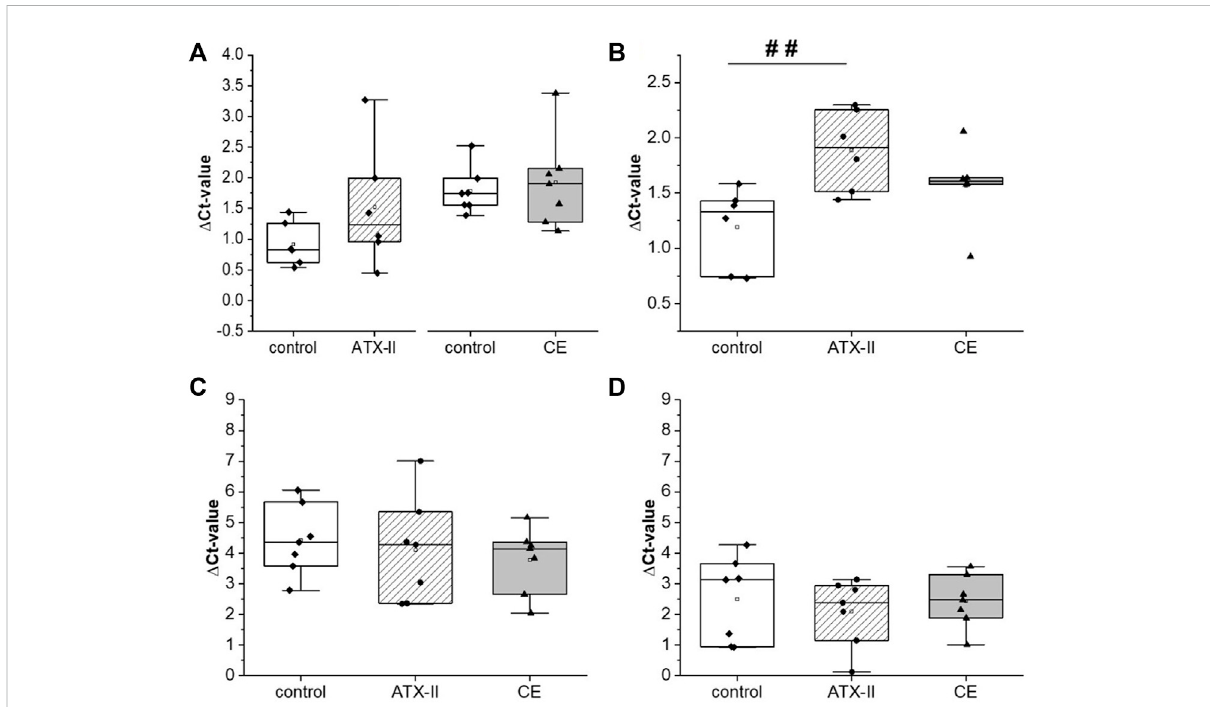
FIGURE 6 The transcription of Cdkn1a in colon (A,B) or liver (C,D) tissue of rats 3 h (A,C) or 24 h (B,D) after oral uptake of either the single mycotoxin altertoxinII(ATX-II)oracomplexextract(CE)ofacultured Alternariaalternata strain.Graphsshow Δ CTvaluesasobtainedwithqRT-PCRasboxplots including single results (7 rats per group) of treated animals incomparison to the control group. After con fi rming normal distributionby theShapiro- Wilk test, signi fi cant differences to the respective control group were calculated by one-way ANOVA, followed by Bonferroni post-hoc testing, and are indicated with “ ## ” ( p < 0.01).